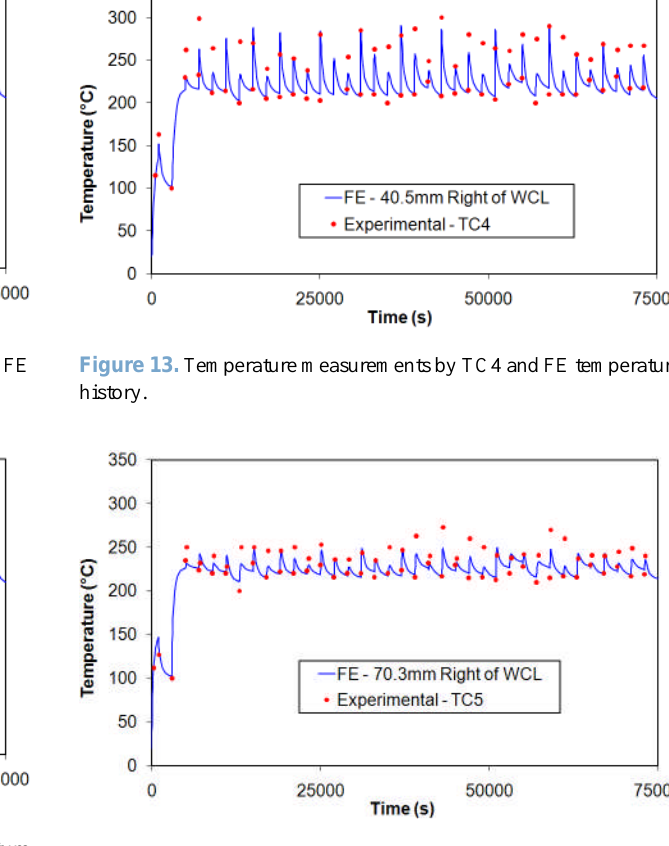
Figure 13. Temperature measurements by TC4 and FE temperature history.